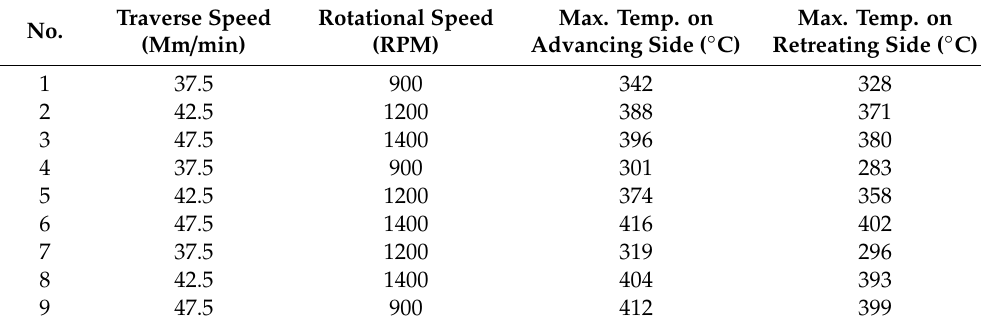
Table 8. Correlation of welding temperature on the selected parameters.